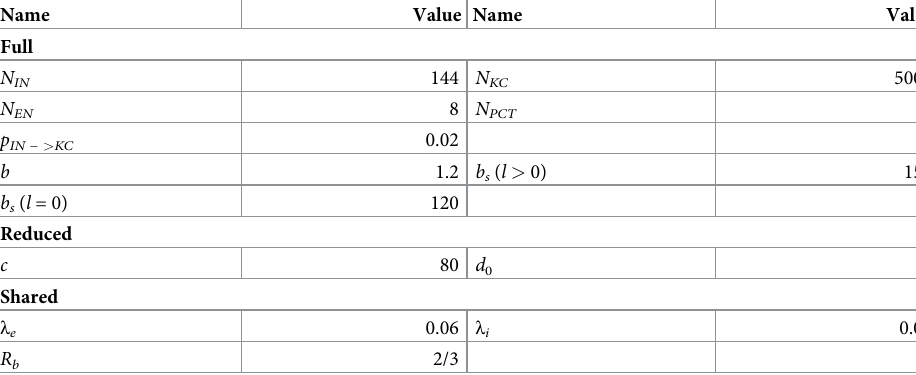
Table 2. Model parameters; all parameters are in arbitrary